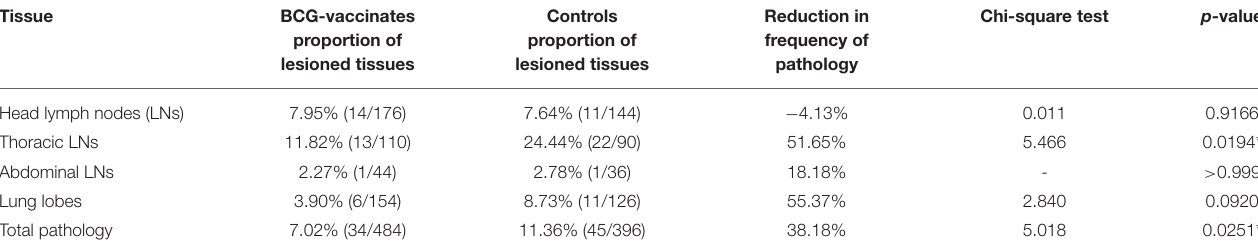
TABLE 2 | The percentage of TB macroscopic lesions in BCG vaccinated and control calves after exposure to an infected herd in a natural transmission setting.